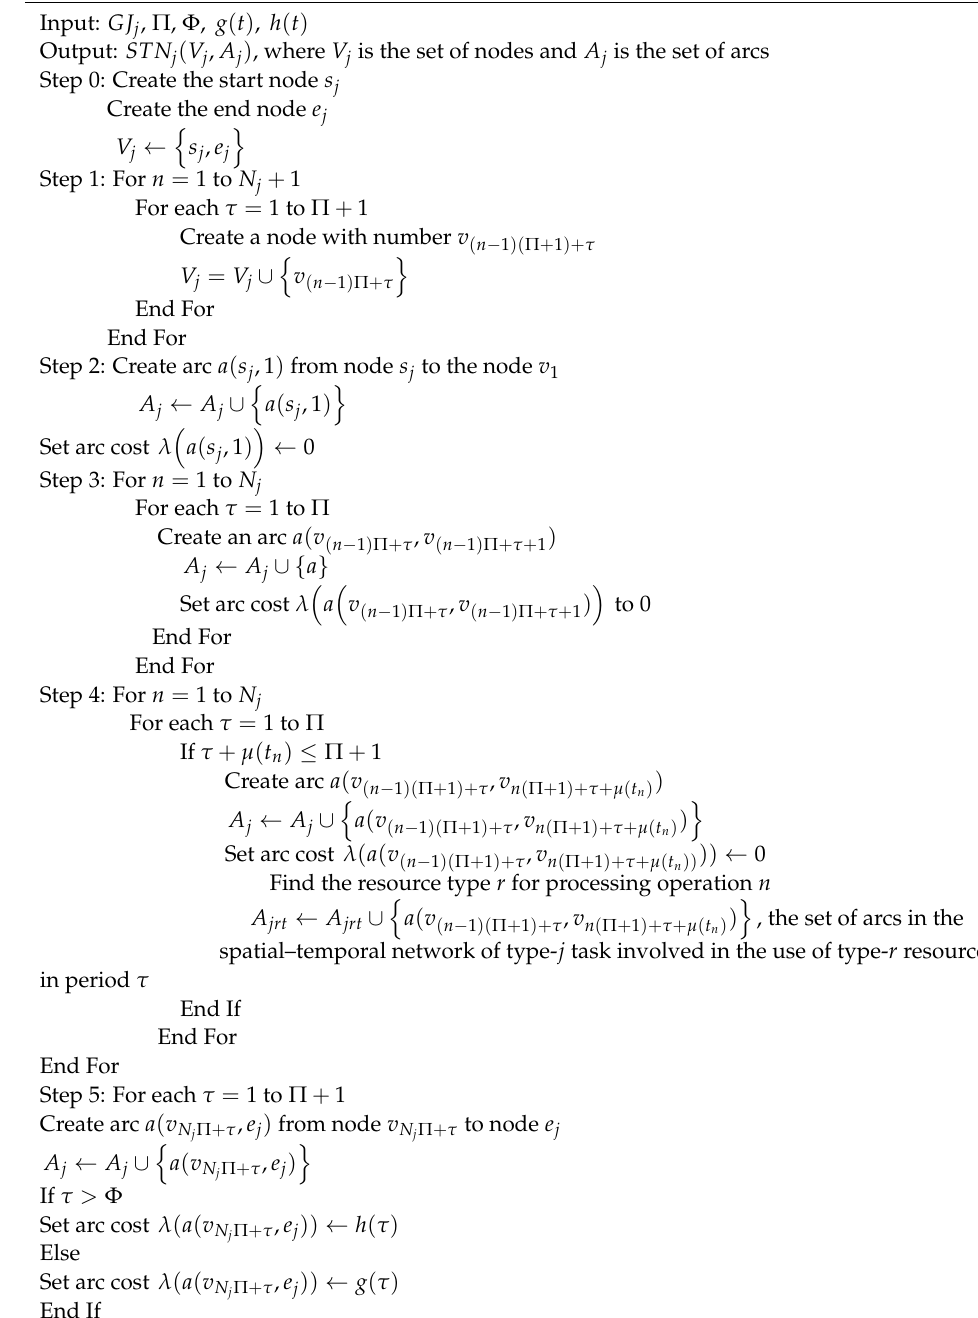
Algorithm 1: Spatial–Temporal Network Construction Algorithm for Type- j Task